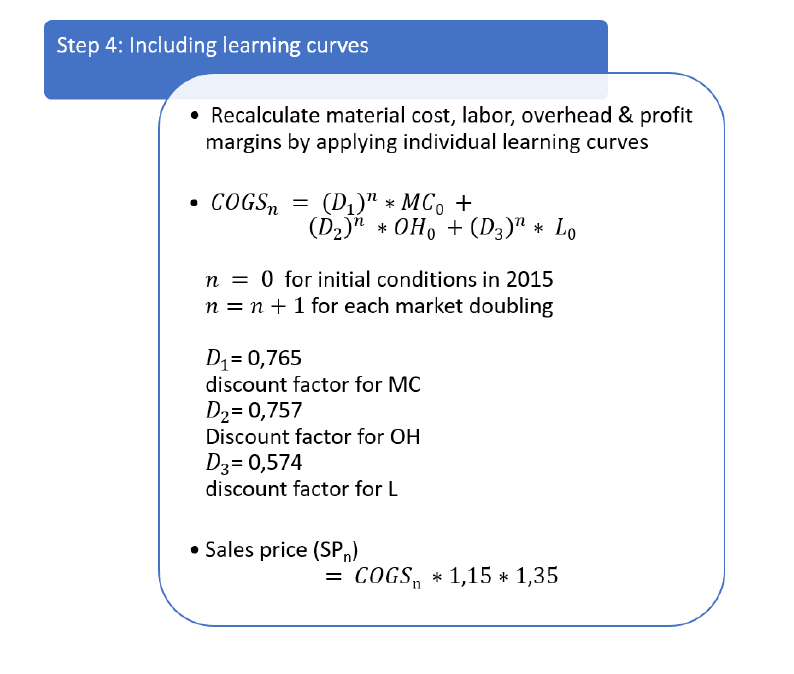
Figure 10. Overview of the used methodology including its key